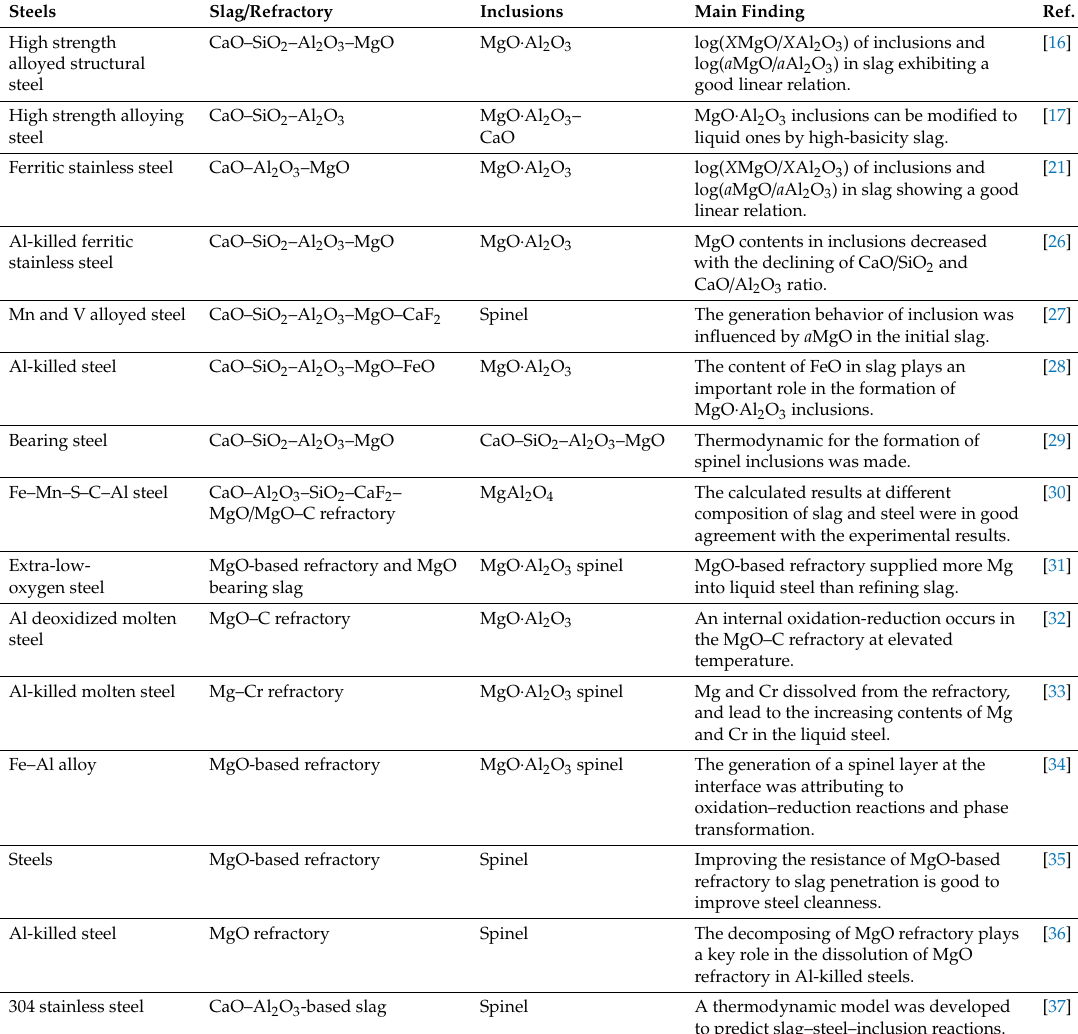
Table 1. The relationships between compositions of slag or refractory and